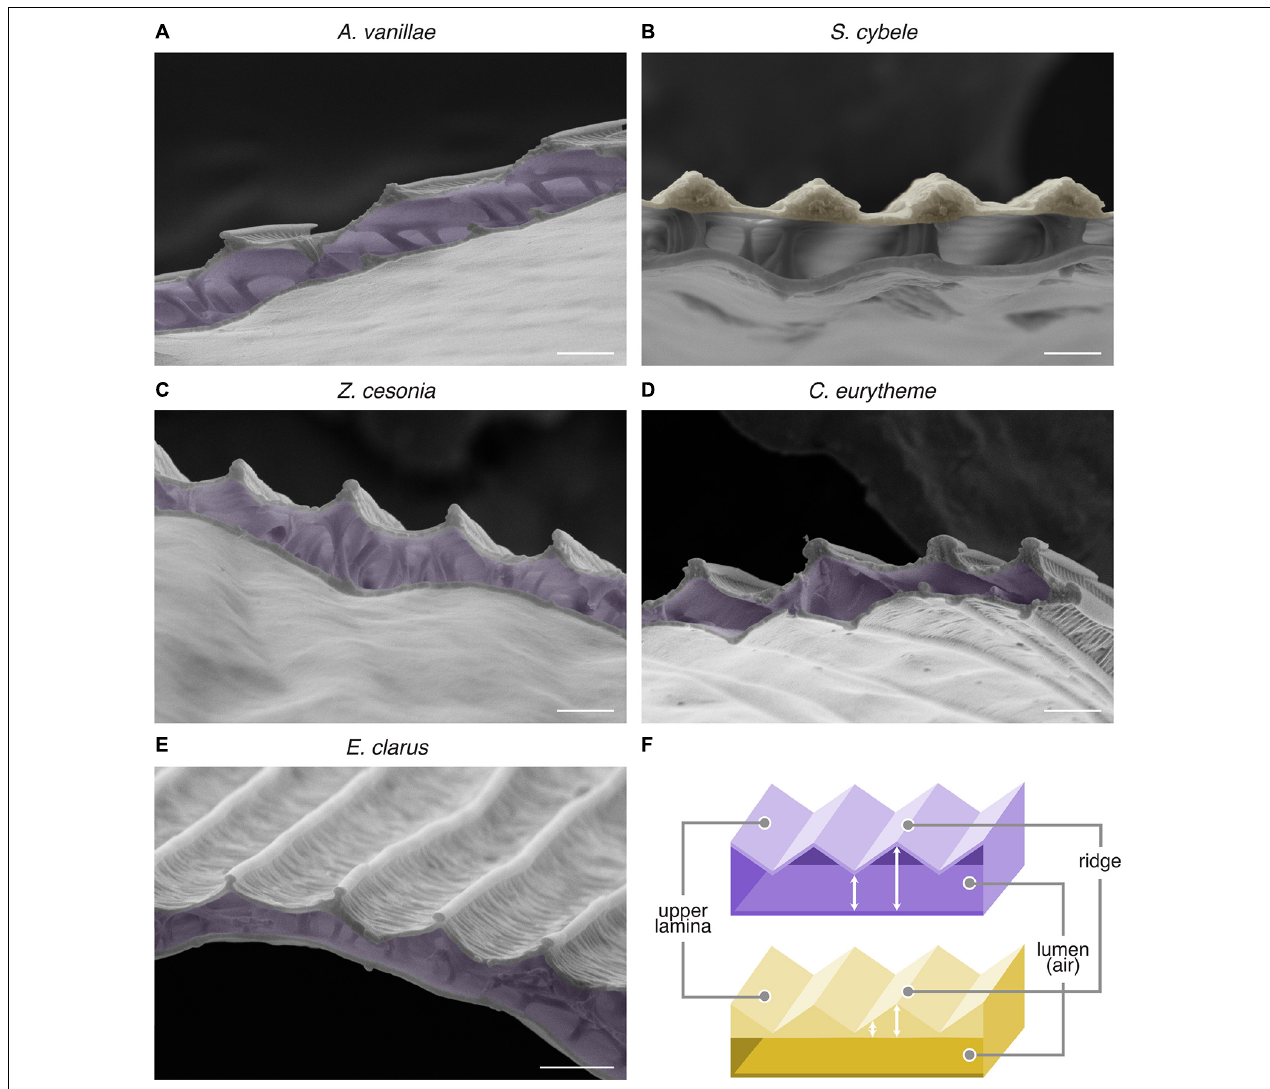
FIGURE 5 | Internal scale anatomy of nymphalid, pierid, and hesperid undulatory thin-film reflectors. (A–E) SEM of transversal sections of the metallic scales of A. vanillae , S. cybele , Z. cesonia , C. eurytheme , and E. clarus reveal the undulatory profile of the specular thin-film. False colors highlight the layer with the most consistent fluctuation in thickness, i.e., the air lumen (purple) in most cases, or for S. cybele , the thickened ridge regions (yellow). (F) Schematic representation of the two types of thin-film thickness undulation as observed in panels (A,C–E) (top, purple) and (B) (bottom, yellow). Scale bars: (A–E) = 1 µ